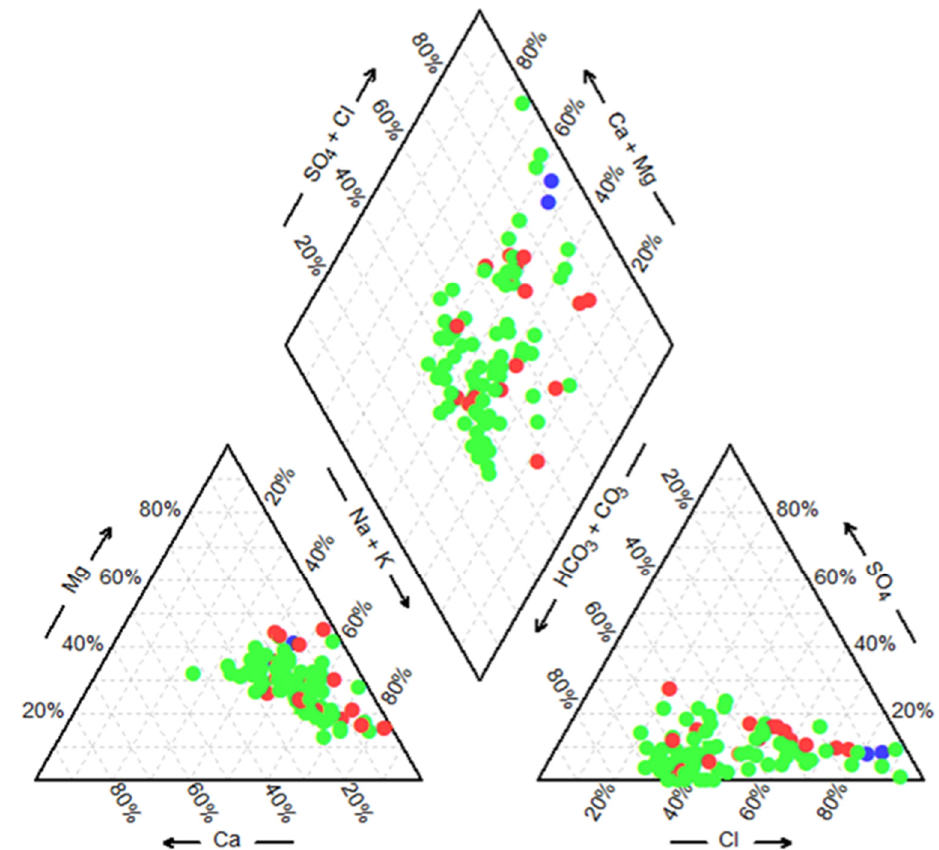
Figure 3. Piper diagram for Santiago Island groundwater samples. The symbols stand for: ( ) base unit formation; ( ) middle unit formation; ( ) recent unit formation.